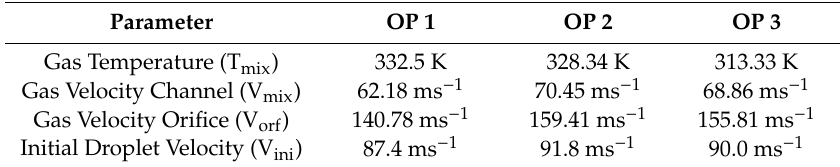
Table 3. Estimated properties of the gas flow inside the nozzle channel, and initial velocities of the droplets for the three operating points (OP).